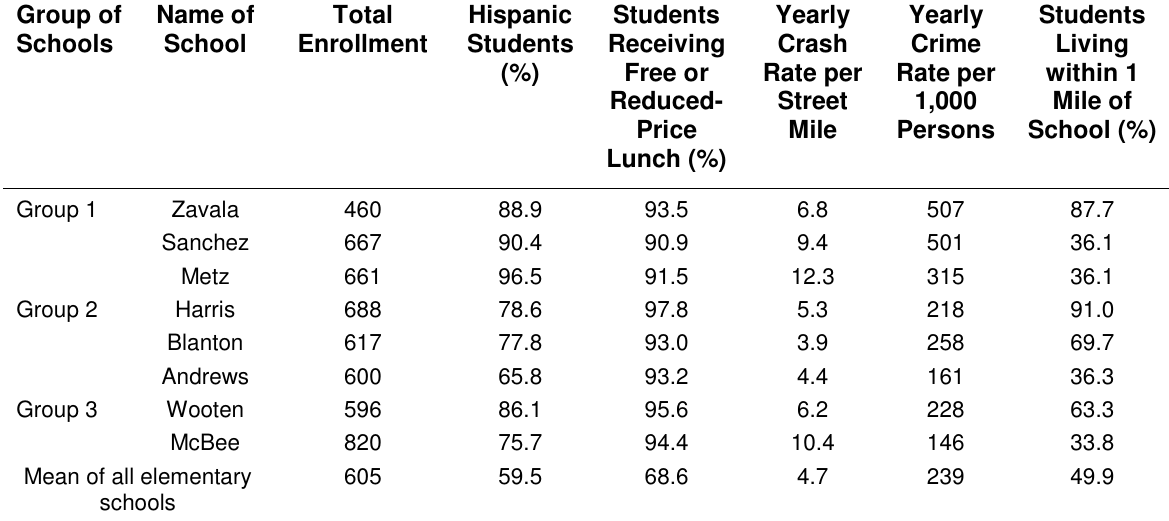
Background Information of Selected Schools Compared to the Mean of all Elementary Schools in Group of